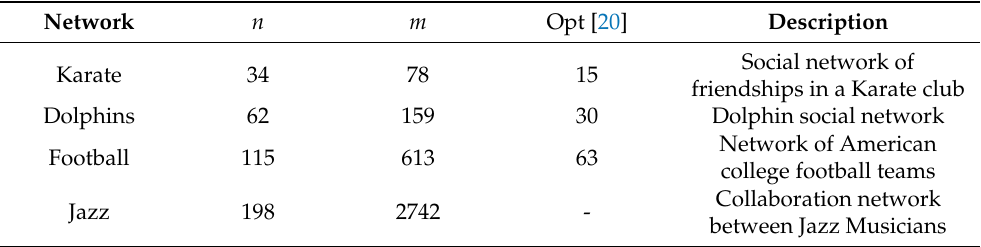
Table 2. Small real social networks used in experiments.